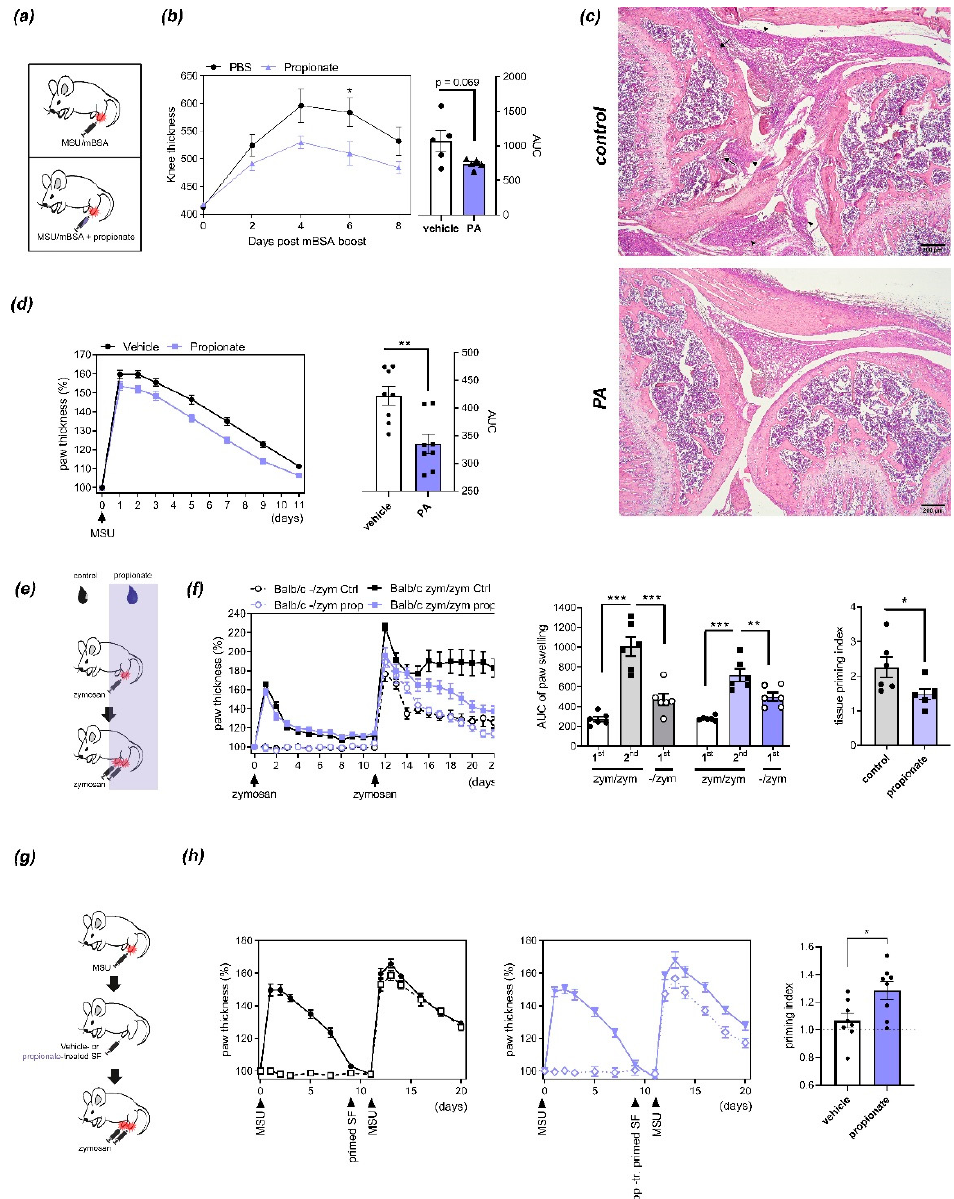
Figure 1. Effects of propionic acid (PA) on arthritis and inflammatory tissue priming: ( a ) Injection schemes for antigen- induced arthritis (AIA) and MSU crystal-induced arthritis. ( b ) Time course (left) and area under the curve (AUC, right) of relative thickness of C57BL/6 mouse paws (n = 5) injected with methylated bovine serum albumin (mBSA) with or without PA. * p < 0.05, ANOVA with Sidak´s multiple comparisons test. p = 0.069, Student´s t -test. ( c ) Inflammatory and bone changes in AIA induced by injection of mBSA with or without PA. Representative H&E staining of sections from mouse paws 8 days after mBSA boost. Black arrowheads indicate inflammatory infiltrates, black arrows areas of bone/cartilage destruction. Scale bars, 200 µm. ( d ) Time course (left) and AUC (right) of arthritis induced by injection of MSU crystals with/without PA. N = 8. ** p < 0.01, Student´s t -test. ( e ) Injection scheme for the inflammatory tissue priming model of arthritis upon treatment with PA in the drinking water. ( f ) Time course of paw thickness (left), AUCs (center) and priming indices (right) during iterated zymosan-induced arthritis in BALB/c mice treated with or without PA in the drinking water (n = 6). Priming index represents the ratio between AUC of the second episode of arthritis and the first episode of arthritis in the contralateral paw. * p < 0.01, ** p < 0.01, *** p < 0.001, ANOVA with Sidak´s multiple comparisons test (AUC); Stu- dent´s t -test (priming index). ( g ) Injection scheme of inflammatory tissue priming by transfer of SFs. ( h ) Course of arthritis (left and center) and priming indices (right) after transfer of primed PA- or vehicle-treated SFs into the naïve paws of recipient mice (n = 8). * p < 0.05, Student´s t -test.